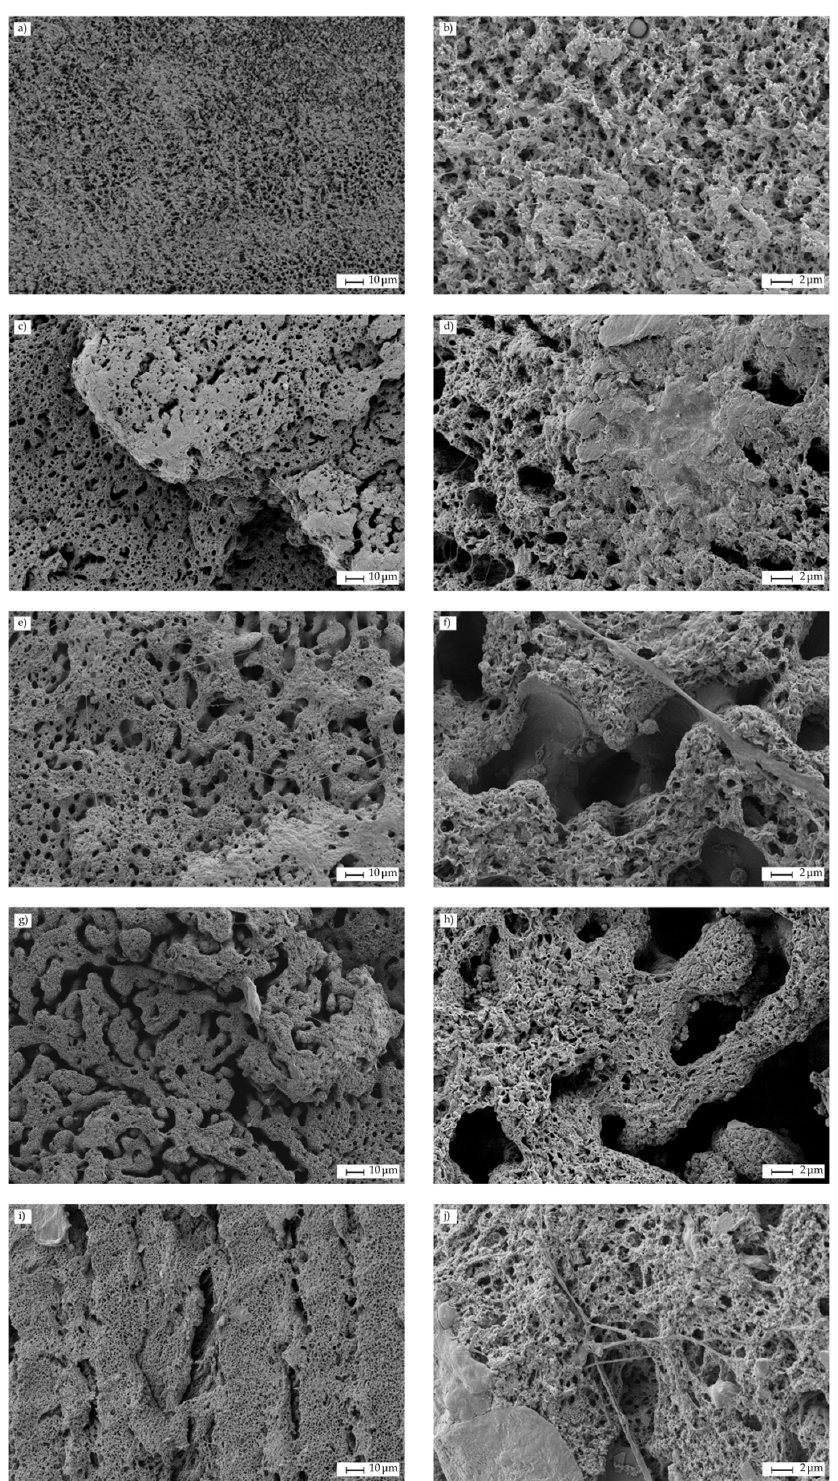
Figure 2. FESEM images of the fractured samples from impact tests corresponding to the PLA 60 /PHB 10 /PCL 30 blend with different compatibilizers at 500 × (left) and 3000 × (right), subjected to selective extraction with glacial acetic acid. ( a , b ) uncompatibilized; ( c , d ) compatibilized with 5 phr ESO; ( e , f ) compatibilized with 5 phr AESO; ( g , h ) compatibilized with 5 phr MSO; ( i , j ) compatibilized with 1 phr ESAO.